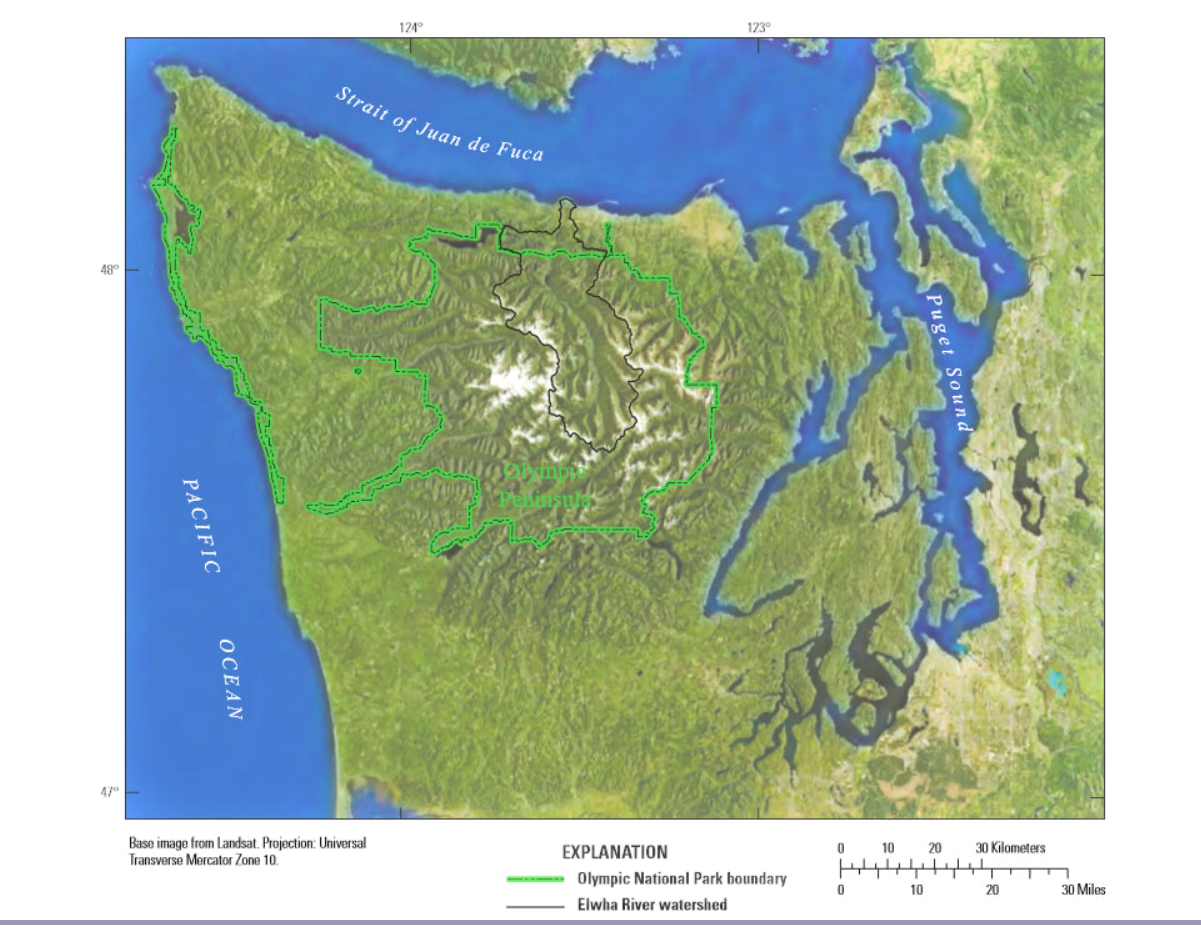
Fig. 2 . Map of the Elwha Watershed and Olympic National